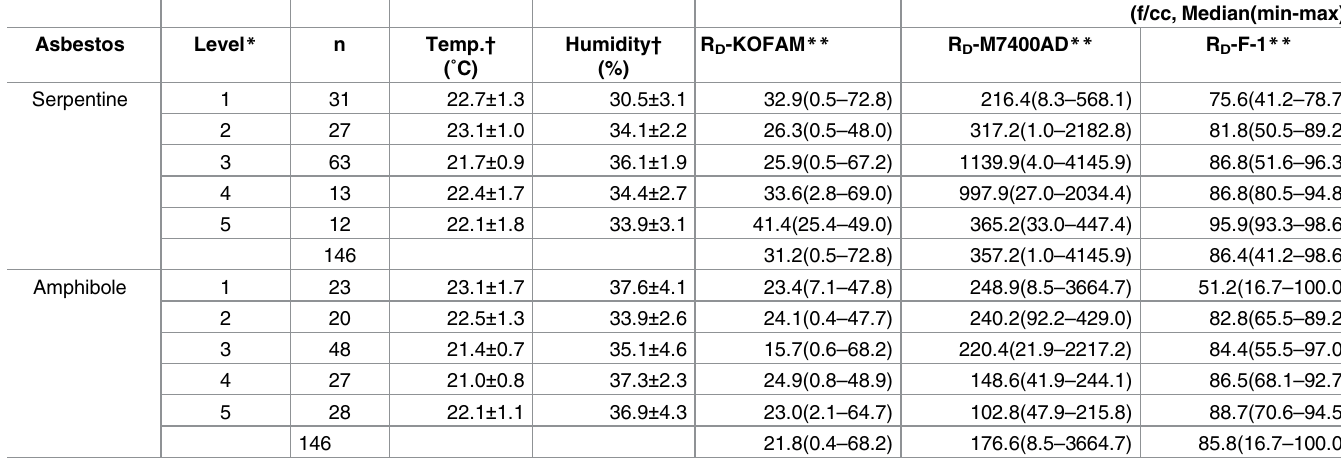
Table 3. Summaryof relative errors of KOFAM, M7400AD, and F-1 on unknown concentration samples.